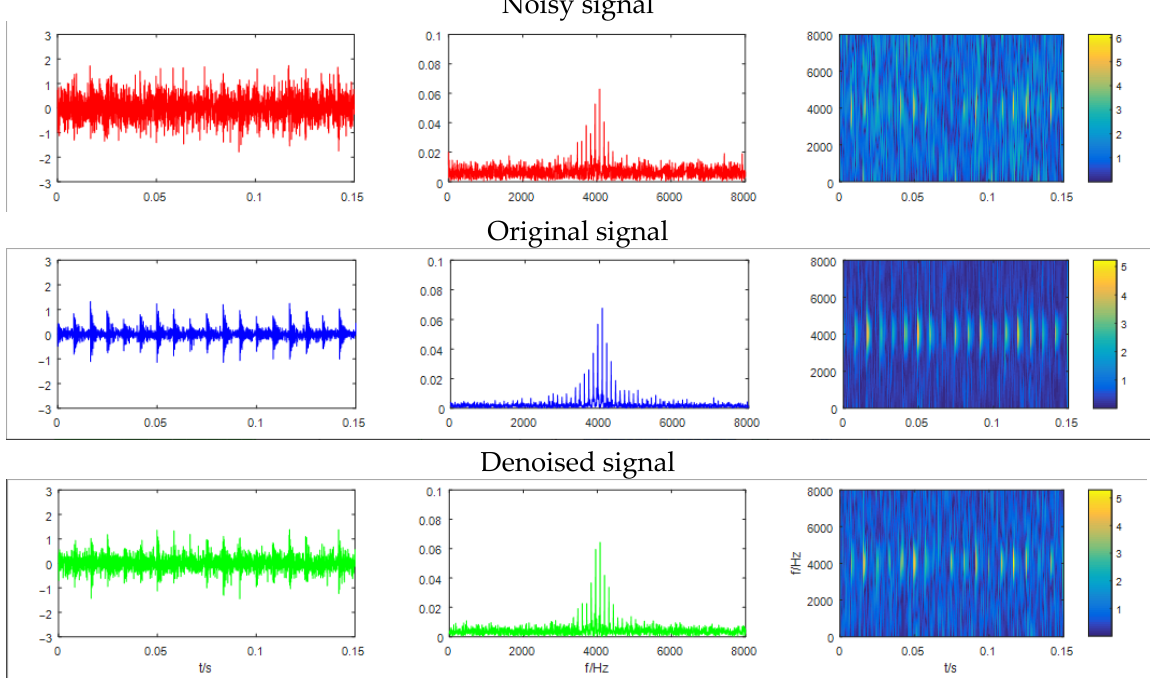
Figure 12. Simulation of signal waveforms, spectrograms and time-frequency diagrams.